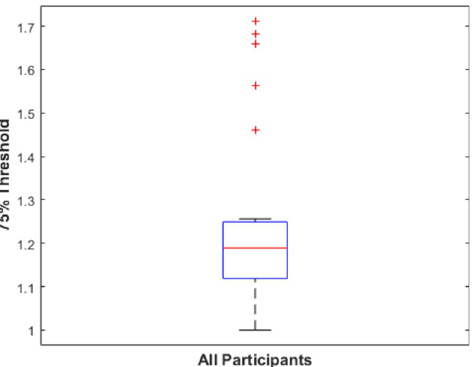
Fig 4. Boxplot of participants’ 75% threshold in Experiment 1. The box shows the interquartile range of thresholds for individual participants. The red line shows the sample median. The whiskers extend to the most extreme datapoint within 1.5 times the length of the interquartile range from the top or bottom edge of the box (covering 99.3% of the data if they are normally distributed) [61, 62]. Outliers are data points beyond the whisker and are plotted as red +’s.